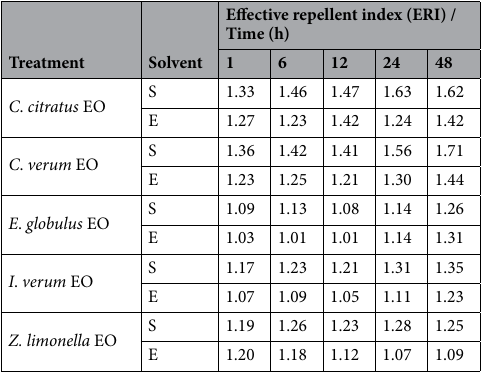
Table 4. Effective repellent indices (ERI) against Periplaneta americana adults of 10% solutions of five plant essential oils (EOs) and in soybean oil and in ethyl alcohol. S Soybean oil formulation, E Ethyl alcohol formulation. ERI = % repellent of each EO formulation/% repellent of cypermethrin.